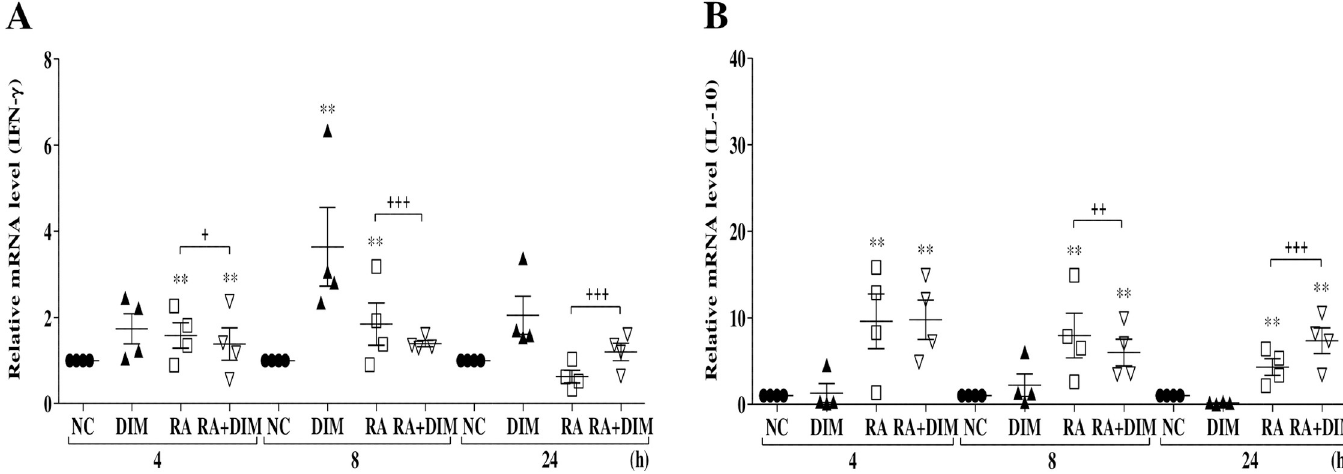
Fig 3. Effect of DIM on IFN- γ and IL-10 expression in splenic lymphocytes. Splenic lymphocytes collected from 2-week-old healthy ducks were stimulated with killed- R . anatipestifer and treated simultaneously with DIM (25 μ M) for the indicated times. Samples were then subjected to qRT-PCR. The levels of IFN- γ (A) and IL-10 (B) mRNA were normalized to that of β -actin and calibrated using the expression levels of unstimulated cultured splenic lymphocytes (NC). Data are expressed as the mean ± SE from four independent experiments with duplicates. �� P < 0.01 compared to NC. + P < 0.05, ++ P < 0.01, and +++ P < 0.001 for comparison of stimulated/ untreated splenic lymphocytes with stimulated/treated splenic lymphocytes. RA, R . anatipestifer ; DIM, 3,3’-diindolylmethane.